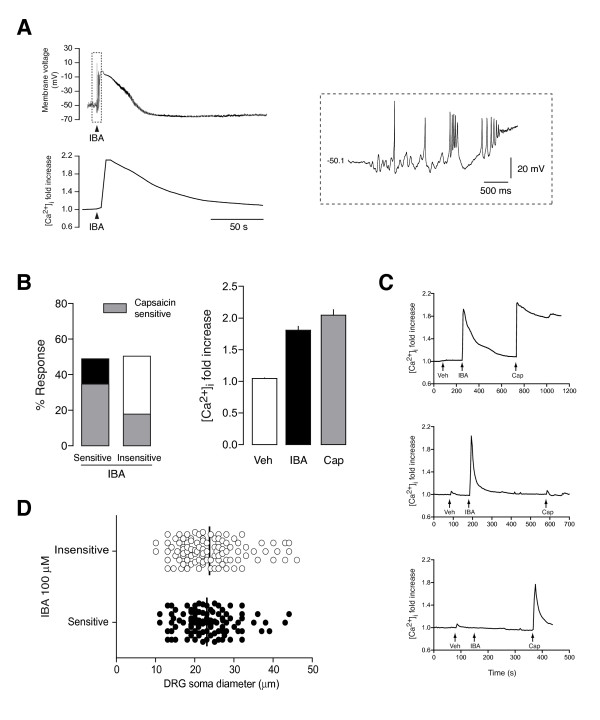
Alkylamide effects on DRG sensory neurons. A. Simultaneous measurement of membrane voltage (top) and intracellular calcium (bottom) in a neuron stimulated with IBA (100 μM). Inset: magnification of the action potentials elicited by IBA application. B. Quantification of intracellular calcium responses to IBA (100 μM) application in DRG neurons in culture (n = 101). Left. Percentage of neurons sensitive or insensitive to IBA application. In each group, the percentage of neurons responding also to capsaicin (Cap; 1 μM) is shown. Right. Intracellular calcium increase (fold-increase vs. resting calcium) elicited by vehicle (Veh) application, IBA (100 μM) or capsaicin (1 μM). C. Representative recordings of intracellular calcium in a neuron responding to IBA and Cap (top), only to IBA (middle) or only to Cap (bottom). D. Soma diameter distribution of DRG neurons sensitive and insensitive to IBA. Black bar shows the mean soma value in each group.